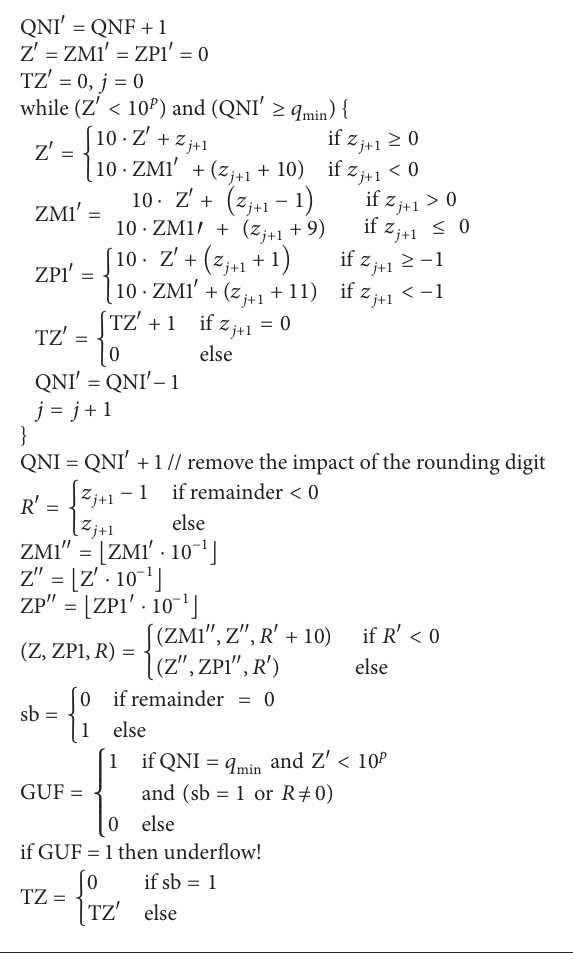
Algorithm 8: On-the-fly conversion with gradual underflow han-